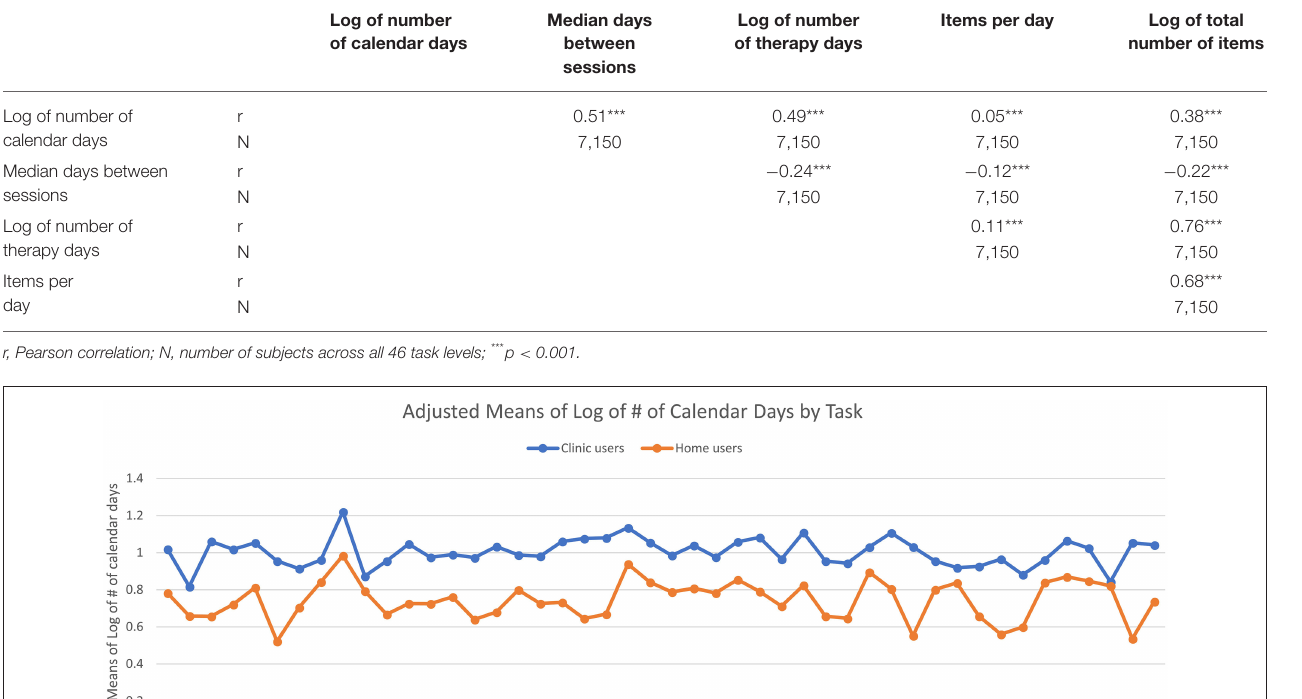
TABLE 3 | Correlation results for log of number of calendar days, log of total number of items, log of number of therapy days, and median days between sessions.